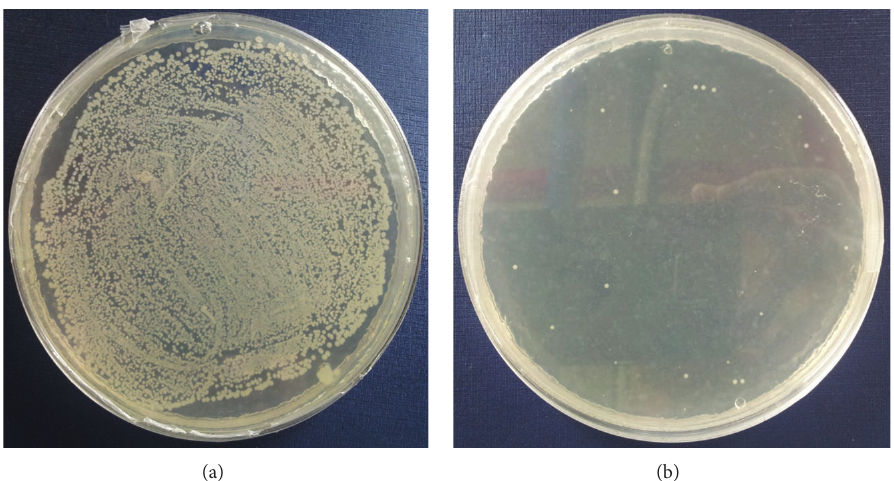
Figure 7: Digital photographs of E. coli (a) without and (b) with CS-CuO hybrid for